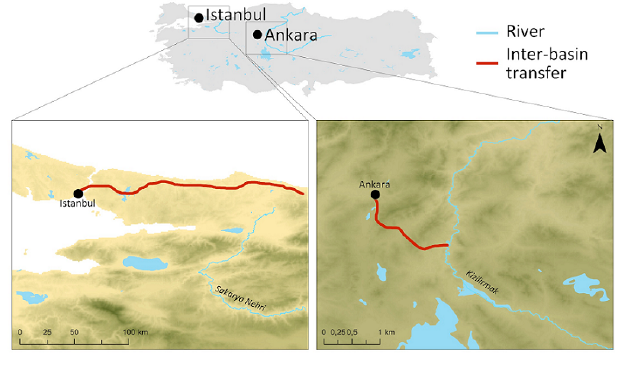
Fig. 2. Location of inter-basin water transfer projects in Melen and Kizilirmak,